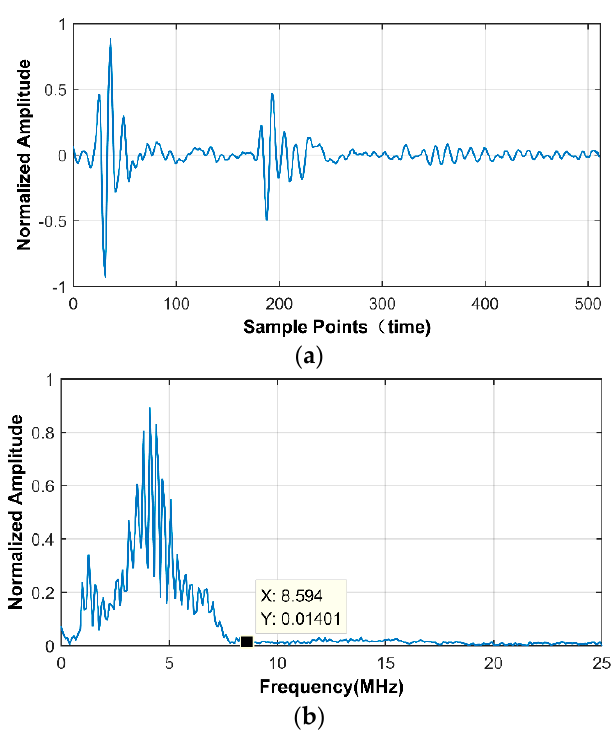
Figure 21. ( a ) Extracted A-scan signal from 20 MHz SR image; ( b ) the DFT spectrum of ( a ).